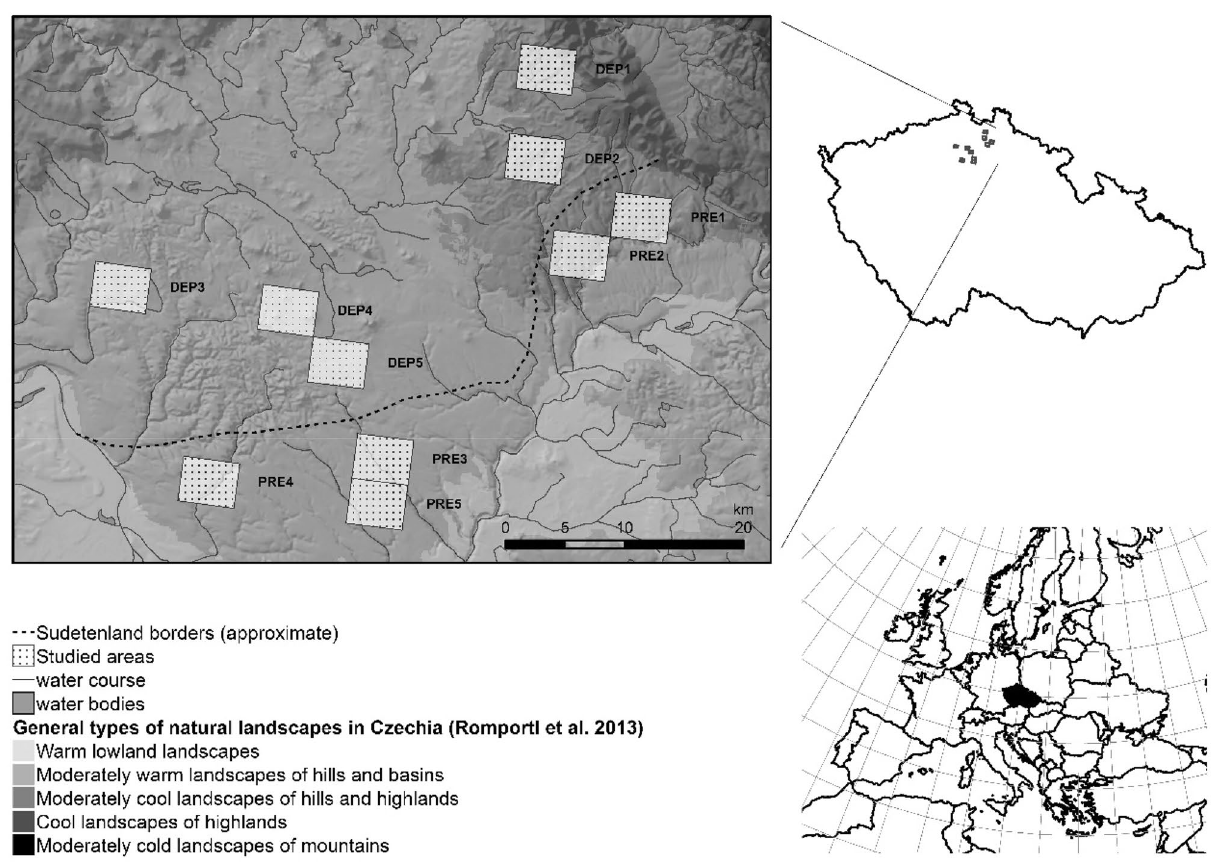
Figure 1. Location of the study sites in Northern Bohemia in Czechia. Study sites in the depopulated region are labelled DEP1–DEP5, sites in the region with preserved population are labelled PRE1–PRE5 (map created in the ArcGIS 10.6 software 34